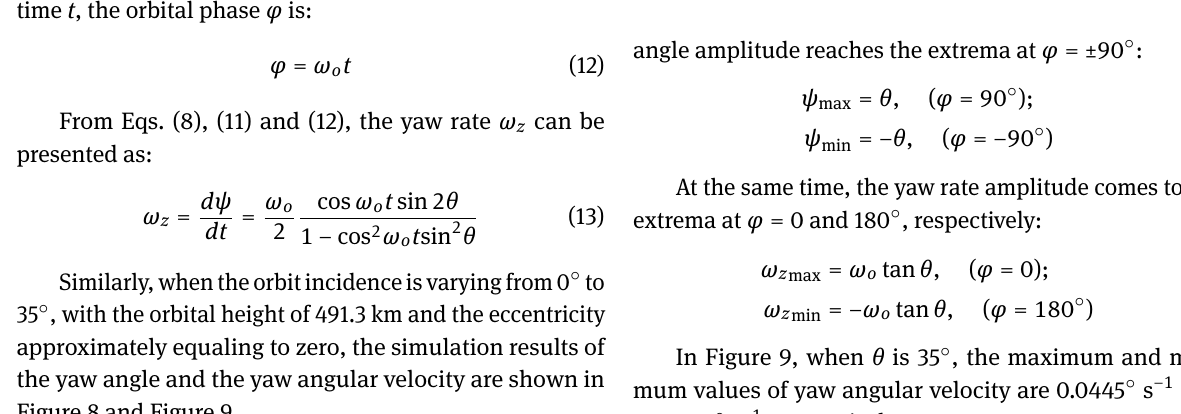
Similarly,whentheorbitincidenceisvaryingfrom0 ∘ to 35 ∘ , with the orbital height of 491.3 km and the eccentricity approximately equaling to zero, the simulation results of the yaw angle and the yaw angular velocity are shown in Figure 8 and Figure 9.